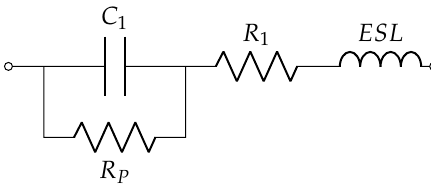
Figure 2. Equivalent circuit of a